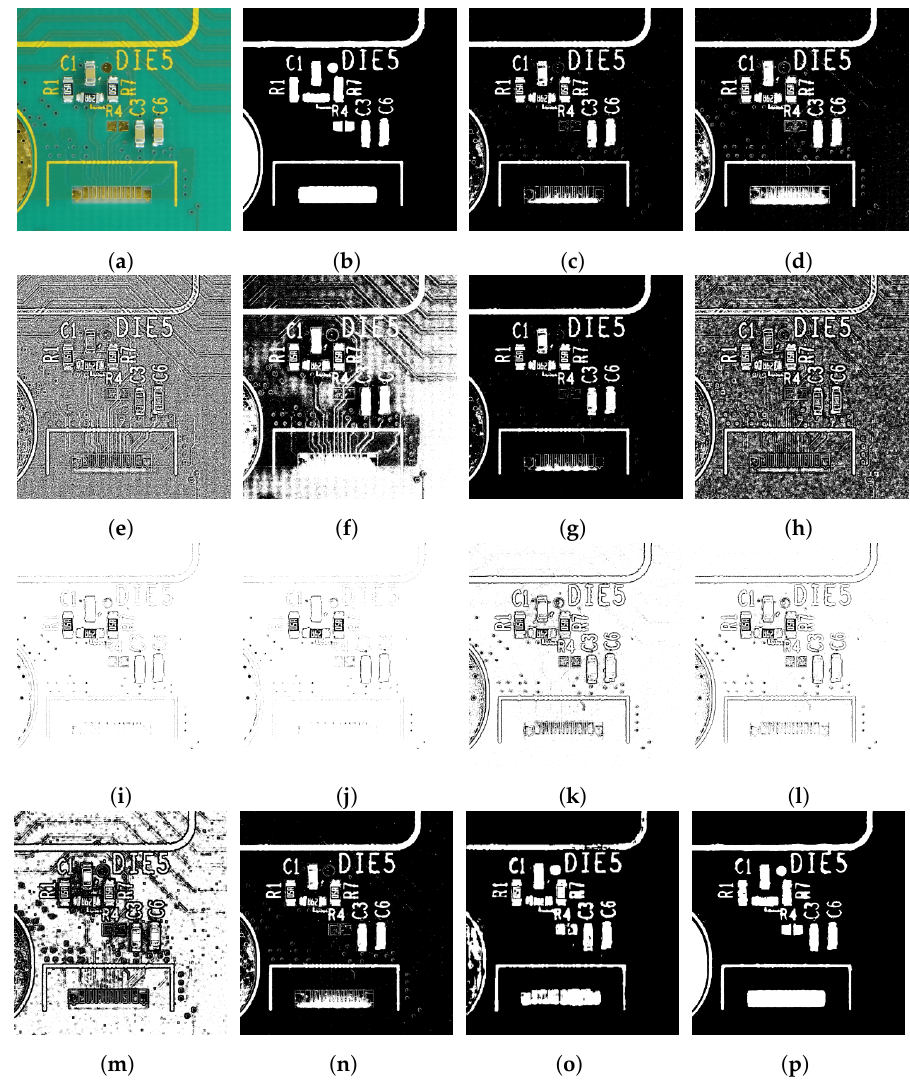
Figure 6. Sample thresholding results using a PCA board image: ( a ) input image, ( b ) ground truth, ( c ) Otsu [11], ( d ) Kapur et al.[12], ( e ) Niblack [23], ( f ) P-tile [27], ( g ) two-peak [27], ( h )